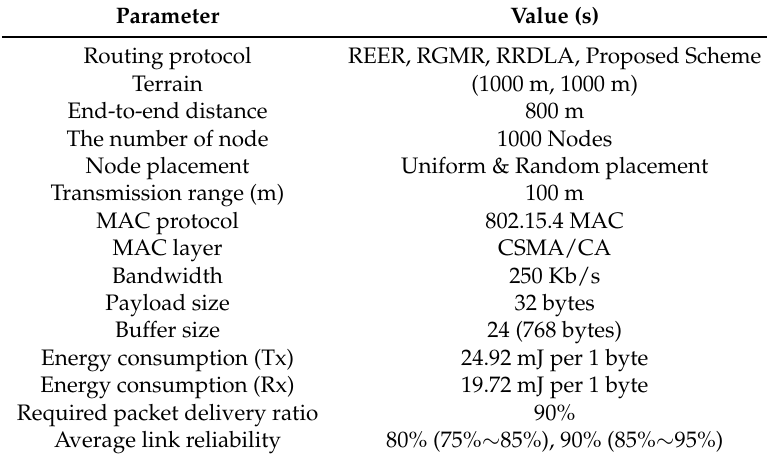
Table 3. Simulation environment setting.